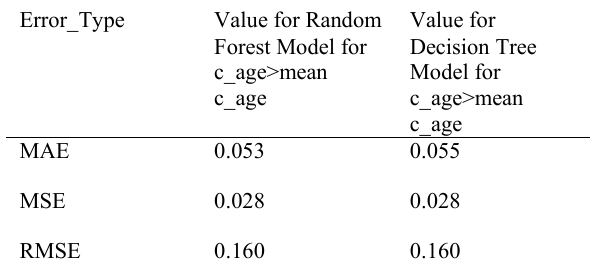
Table 5. Values of MAE, MSE, RMSE for overall data set for the Random Forest and Decision Tree Models